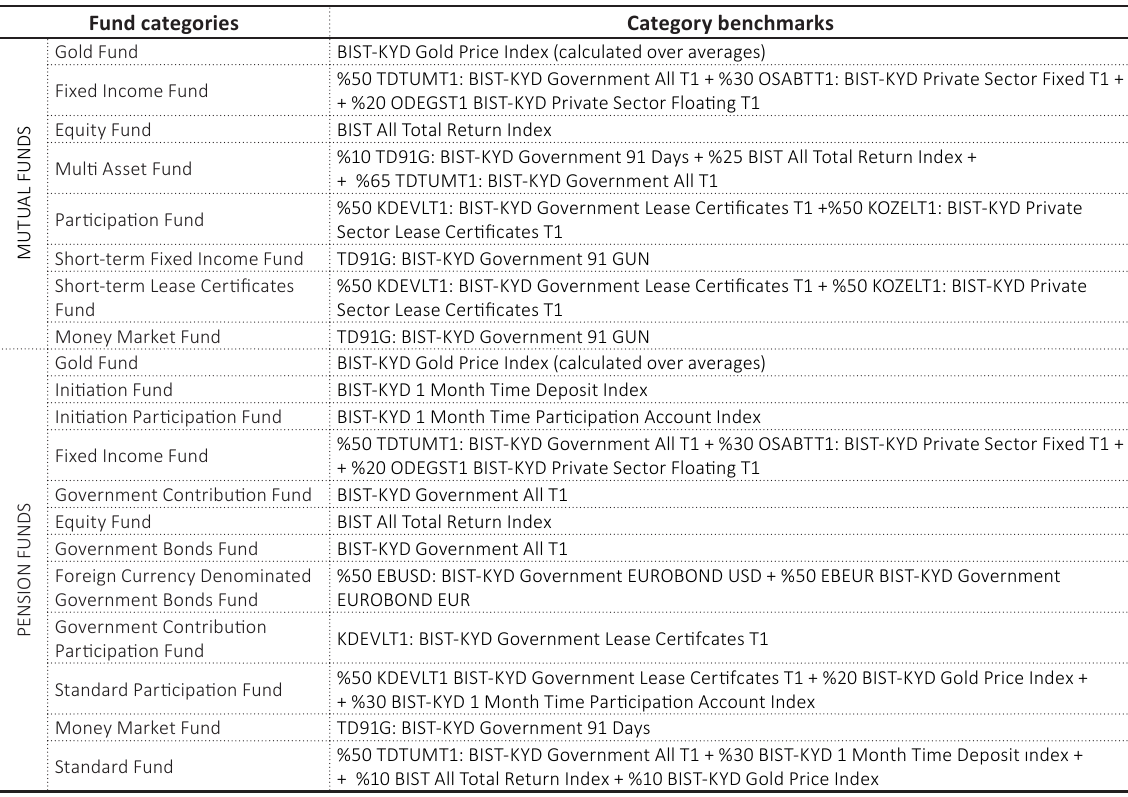
Table 2. Defined category benchmarks Source: Authors defined benchmarks utilizing indices announced and calculated by Borsa